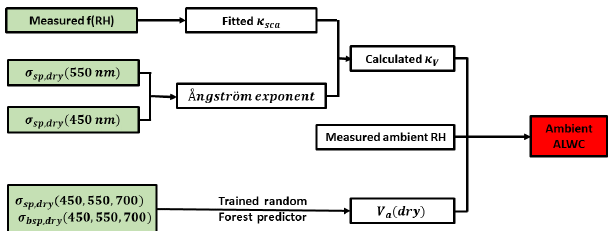
Figure 8. The flowchart of calculating ambient aerosol liquid water contents based on measurements of a three-wavelength humidified nephelometer